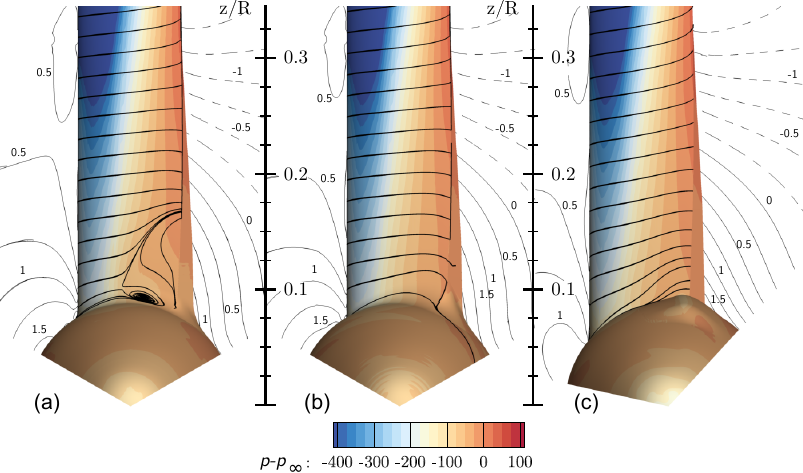
Figure 29. Visualization of three-dimensional flow in the root region using streamlines and pressure contours for CaseT1.0-rounded (a) , CaseT1.0-fairing (b) and CaseT1.0-dYm05 (c) . The contour lines indicate the “deviation velocity” e w from to the ideal kinematic value − (cid:127)y in a slice at x =